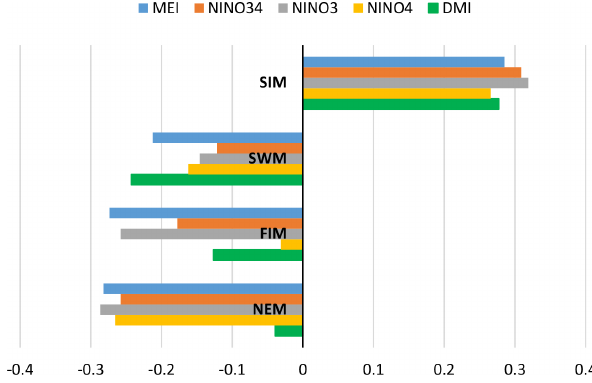
Figure A3. Correlation between Norwood rainfall anomalies with multiple climate